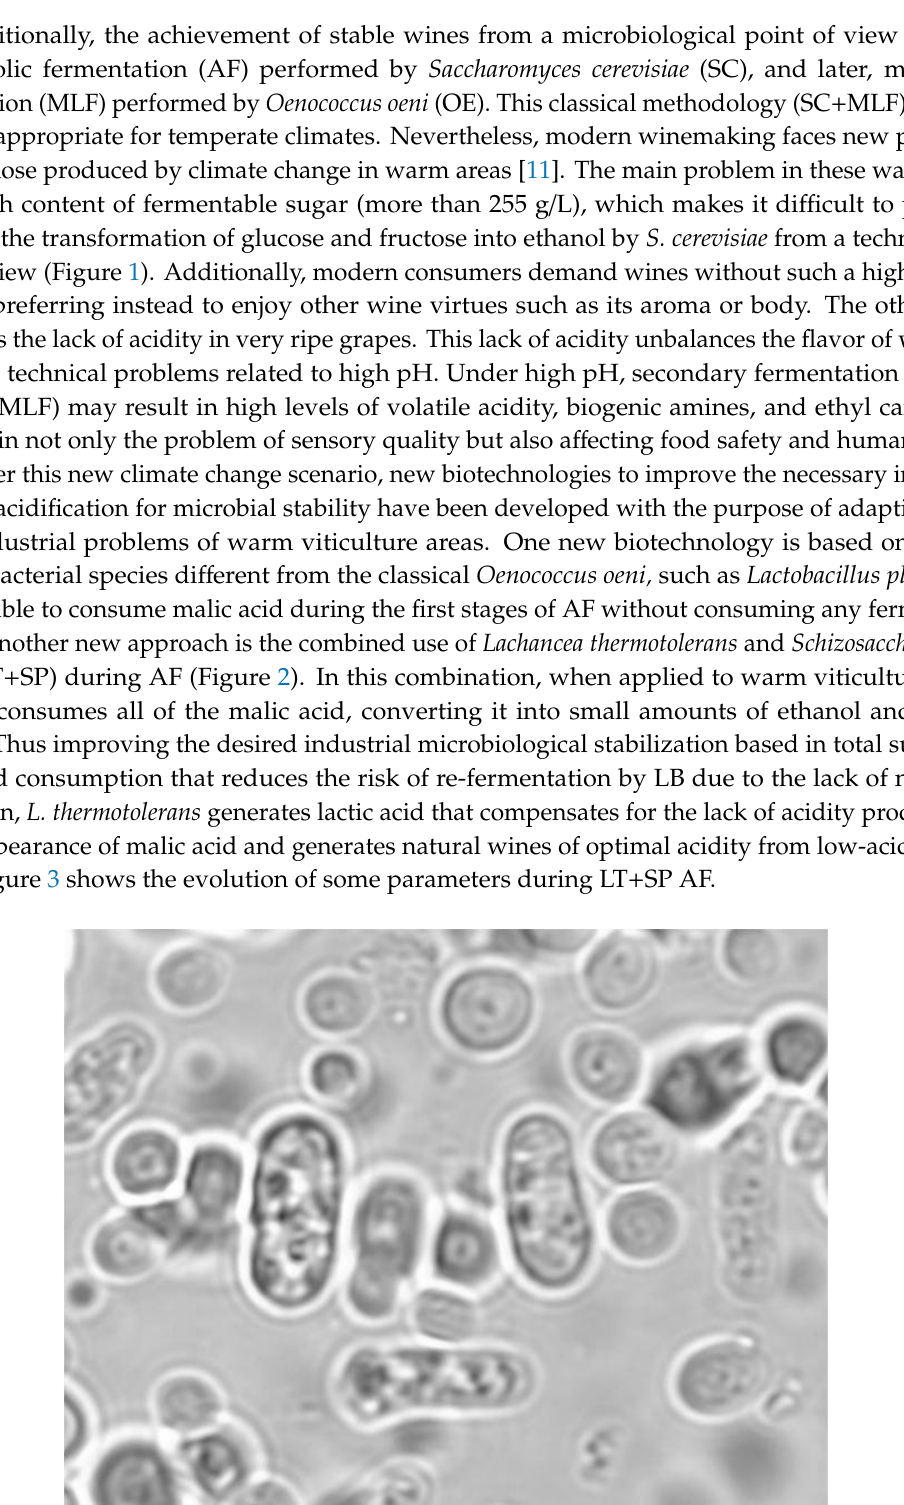
Figure 3. Kinetics of fermentable sugars, lactic acid, and malic acid during alcoholic fermentation combining Lacchancea thermotolerans and Schizosaccharomyces pombe . The biotechnology that combines the use of L. thermotolerans and S. pombe (LT+SP) was performed for the first time in 2015 [30,31], and basic wine quality parameters such as malic acid, lactic acid, pH, glycerol, and color intensity were studied. The ensuing studies started to research more advanced parameters such as wine volatile compounds [32], amino acids [32], biogenic amines [30,32], anthocyanins [33–35], or polysaccharides [36]. Studies regarding the new biotechnology started following a similar evolution as that which took place in the past for the classical methodology (SC+MLF) based on AF by S. cerevisiae and MLF by O. oeni . Additionally, several different researchers have utilized the new methodology [34,37–39] during recent years, making possible a comparison